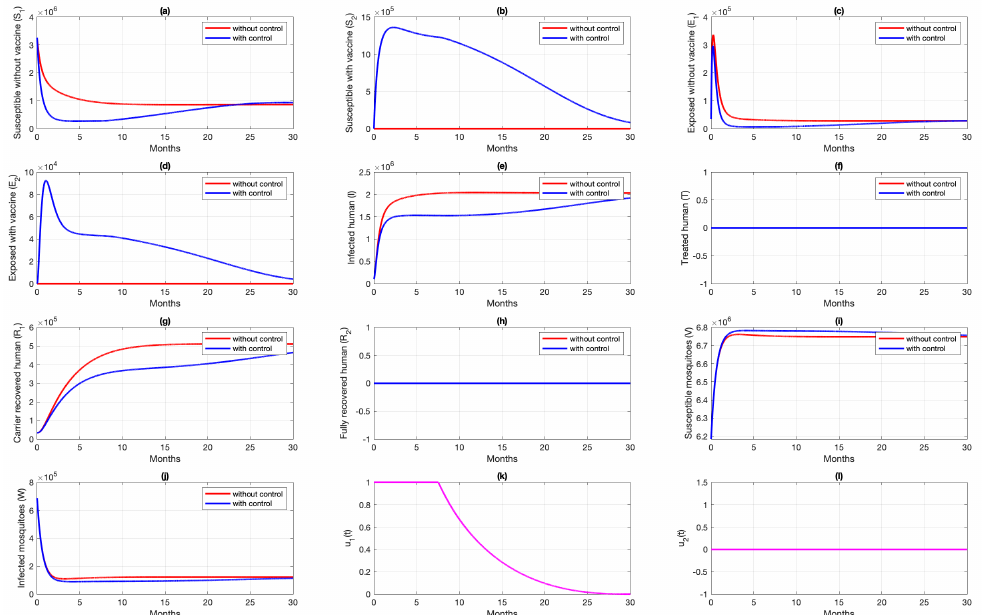
Figure 8. Dynamics of human ( a – h ), mosquitoes ( i , j ), and controls ( k , l ) under the scenario of pre-erythrocytic vaccine intervention only applies. Blue and red curve represents implementation strategies with and without controls.